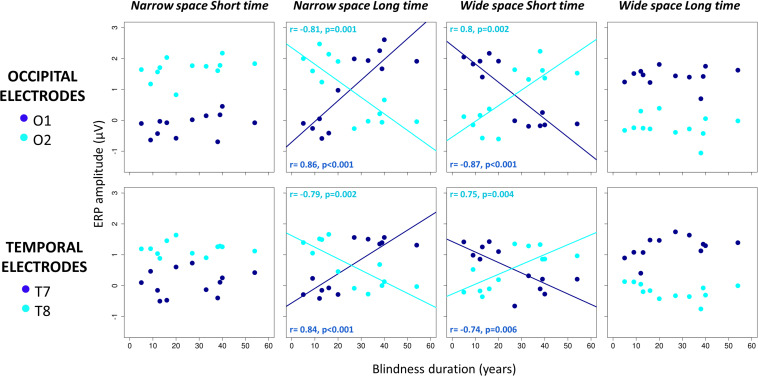
Correlations between years of blindness duration and mean ERP amplitude in occipital (top) and temporal (bottom) electrodes 50–90 ms after S2 of the spatial bisection task. For each participant and condition (narrowSpace_shortTime, narrowSpace_longTime, wideSpace_shortTime, wideSpace_longTime), ERP amplitude in O1/T7 (dark blue) and O2/T8 (cyan) is plotted against years of blindness duration. Lines indicate significant correlations. For each correlation, we report Pearson correlation coefficient (r) and significance level (p).